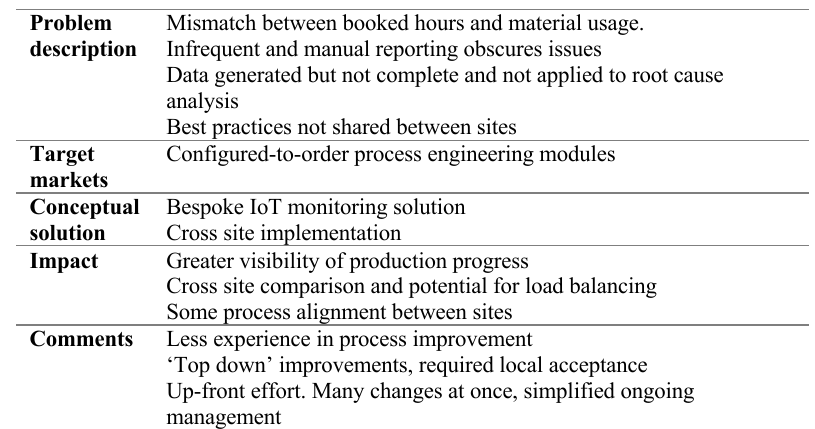
Table 4. Contextual description for case